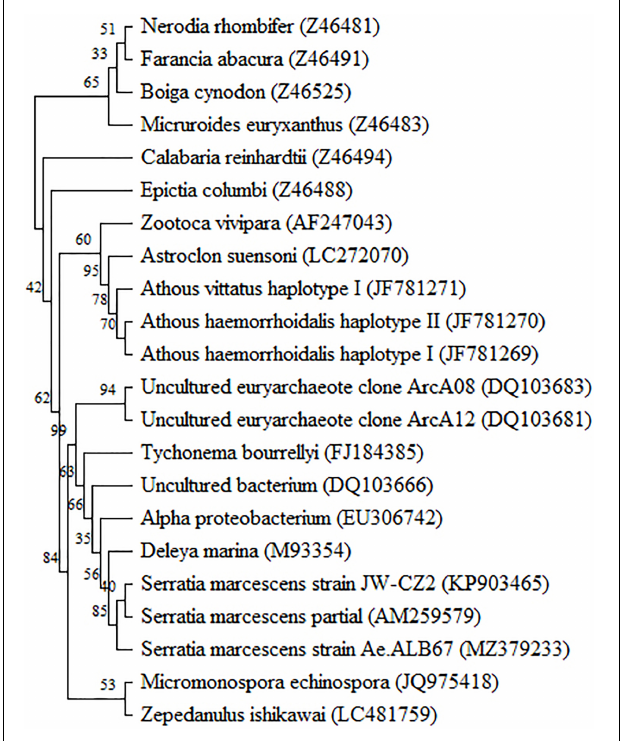
FIGURE 2 | Phylogenetic tree based on the 16S rRNA sequences of J W-CZ2 and other bacterial strains. The GenBank accession numbers for nucleotide sequence data are shown at the beginning of each species.